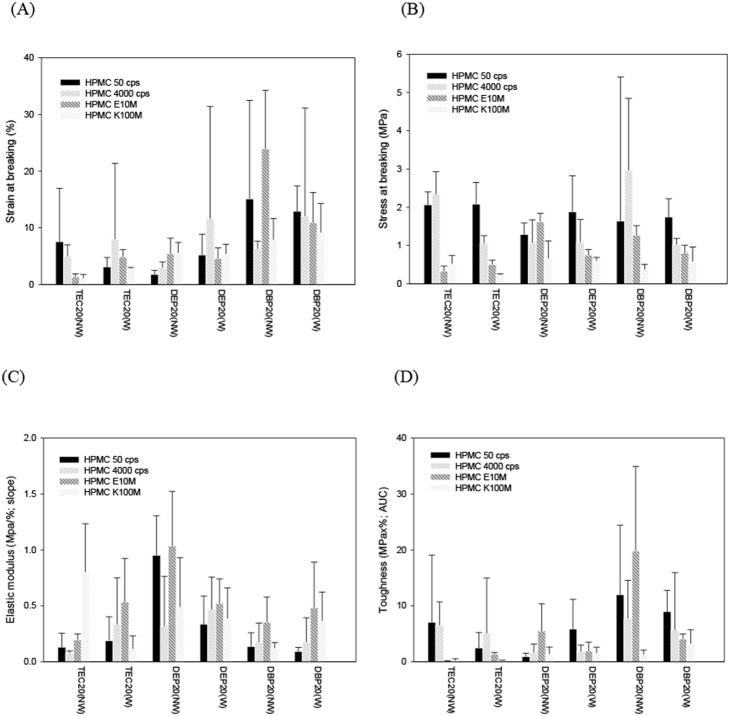
Mechanical properties of wet-state films composed of ethyl cellulose and different grades of HPMC.(A) Strain at breaking (%), (B) stress at breaking (MPa), (C) elastic modulus (MPa/%; slope), (D) toughness (MPa×%; AUC) (n = 4).